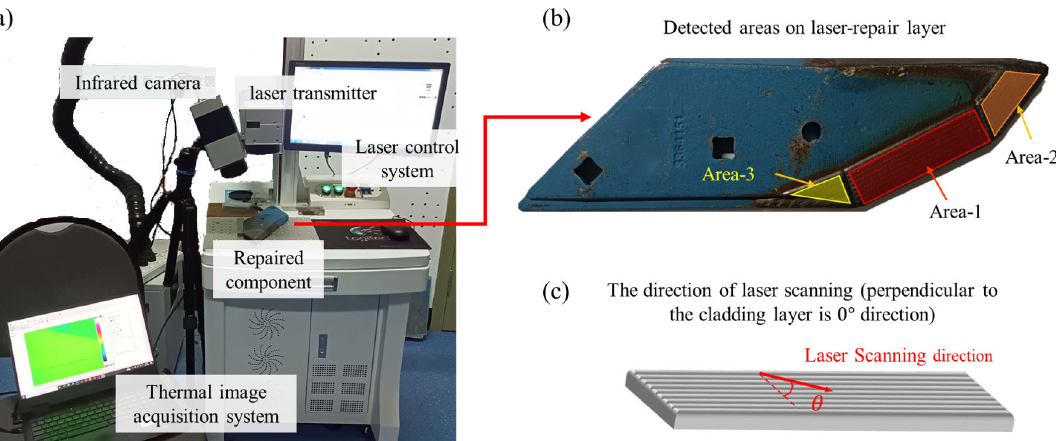
Figure 12. Experimental system: ( a ) laser thermography system; ( b ) laser ‐ repaired component; ( c ) Setting of laser scanning direction.